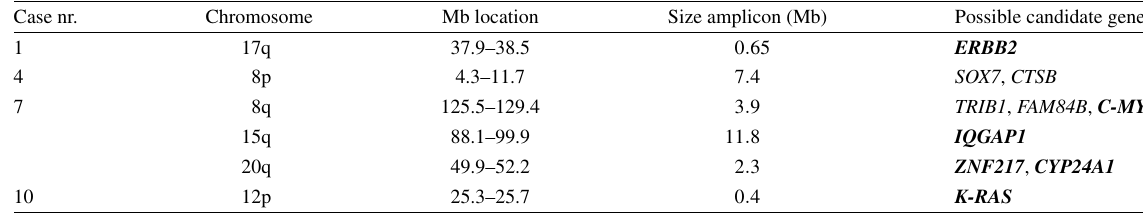
Mixed gastric carcinomas with one or more amplified regions